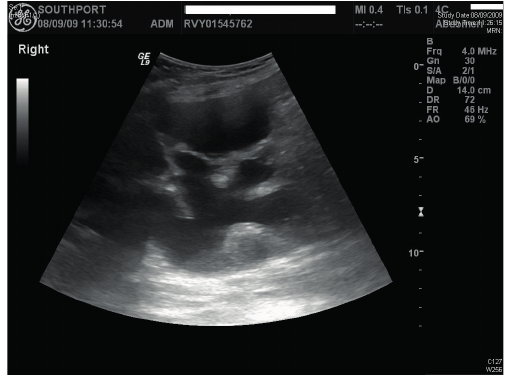
Figure 1: Ultrasound of urinary tract performed in 2009 revealed marked hydronephrosis of right kidney and bilateral renal cortical cysts.